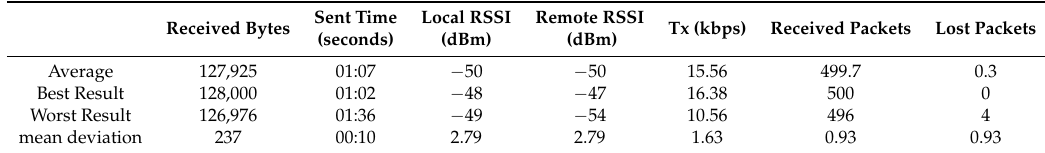
Table 8. Results obtained in scenario 1.